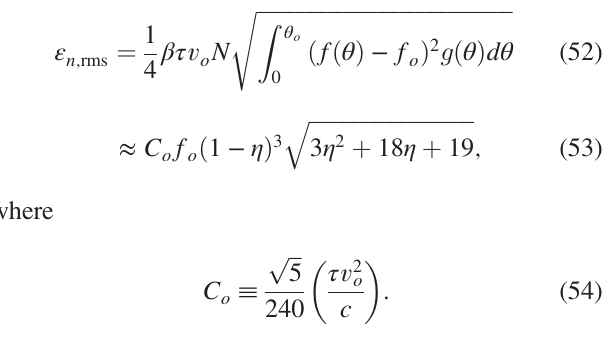
radius — rather, the length scale is set by mc 2 =F — and dependent on the product of two factors: the first is a ∝ v 3 =F and the second is a factor depen- coefficient C o o dent only on η . The behavior of the latter is indicated in Figs. 6, 7, and 8 for thermal, photo, and field emission =C f parameters, respectively, in which the ratio ε , n; rms o o calculated directly from Eq. (52), is shown as a function of F for fields representative of each technology; although Eq. (52) is well approximated by Eq. (53) (as shown in Fig. 9 for representative fields of each emission mechanism), f the red line also shown is the ratio of Eq. (53) with C to o o show the approach to the asymptotic limit. The representa- tive fields are ½ F (cid:2) ¼ 0 . 1 eV = μ m, ½ F (cid:2) ω ¼ 10 eV = μ m, and T ½ F (cid:2) ¼ 1 eV = nm, for thermal, photo, and field emission, F respectively, as indicated by the subscript: the use of representative fields allows the x axis in the figures to be standardized, as in F ¼ χ ½ F (cid:2) for “ x ” representing the x emission mechanism and χ ranging from 1 to 10.